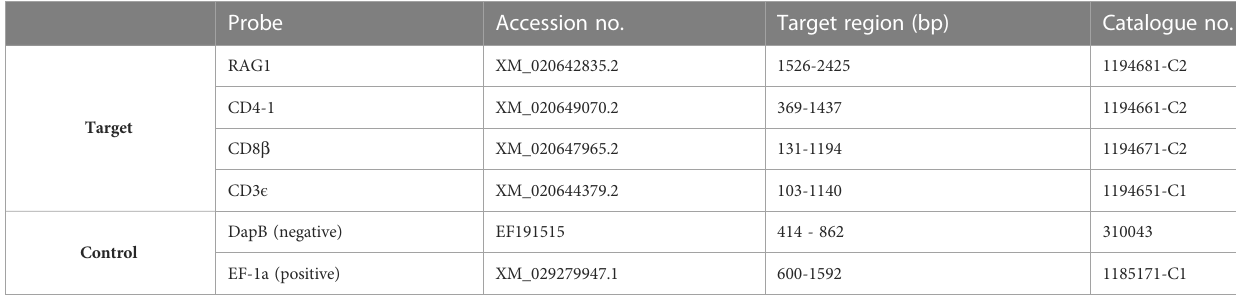
TABLE 1 Probes used in in situ hybridization ( Labrus bergylta